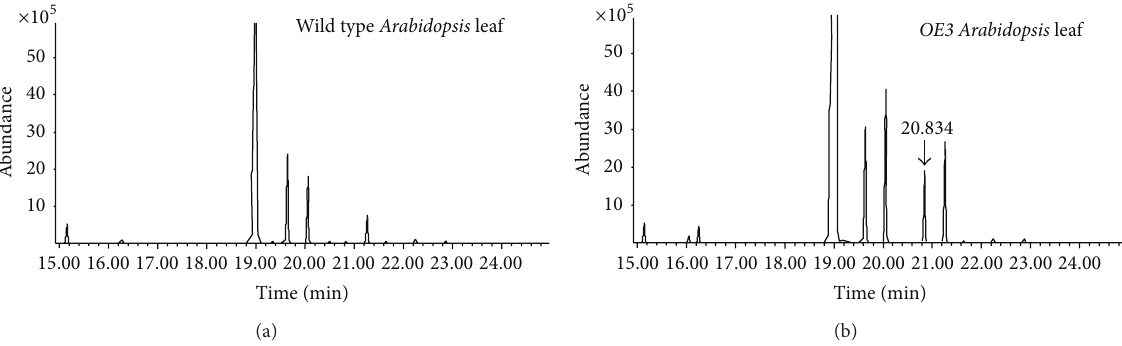
Figure 9: GC-MS chromatograms of the transgenic OE 3 (b) and a wild type plant (a). The arrow ( ↓ ) indicates the peak at the retention time of 20.834 that shows high match with 𝛽 -sesquiphellandrene in the NIST/EPA/NIH library.